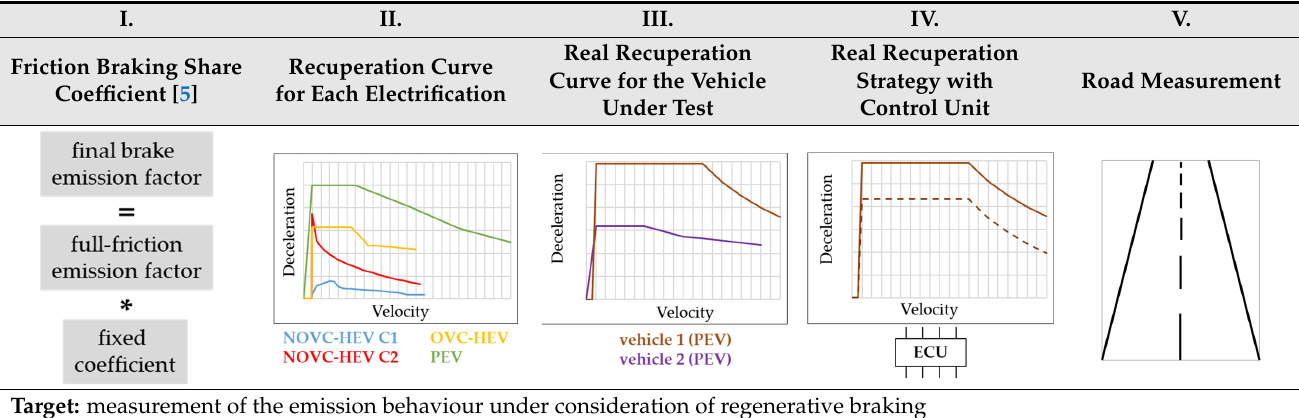
Table 12. Proposed future steps for consideration of real electric braking. I.